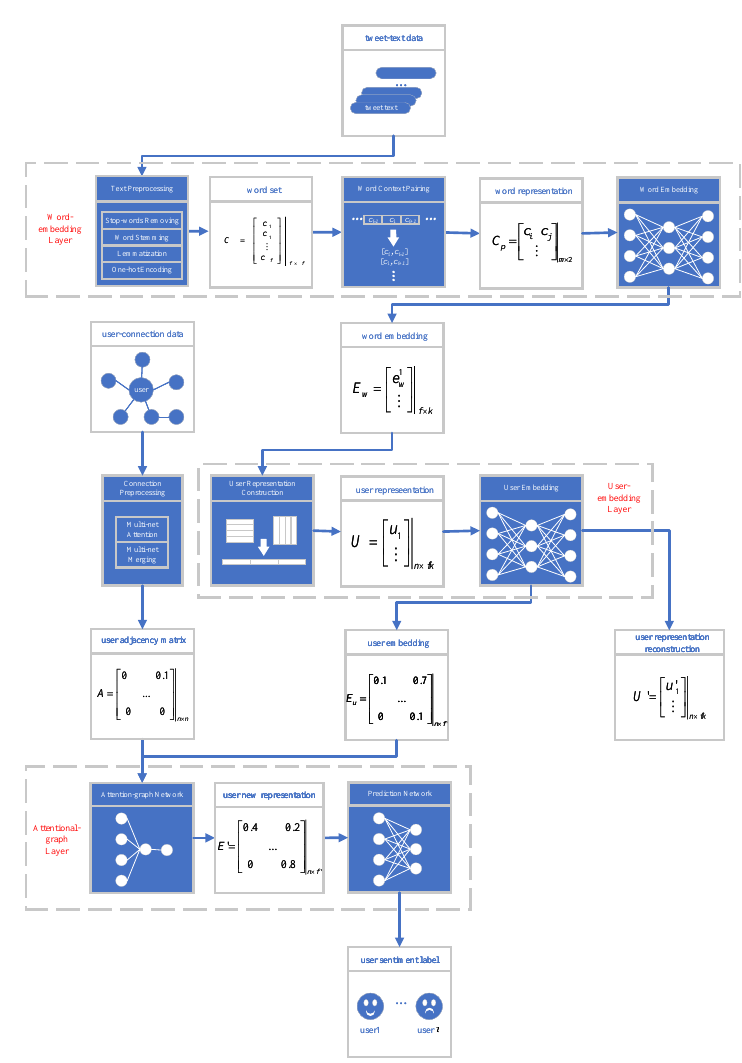
Figure 1. An illustration of the forward-pass workflow of Attentional-graph Neural Network based Twitter Sentiment Analyzer (AGN-TSA) (forward pass). Noting that the blocks with transparent background refers to data, and those with blue background are the processing